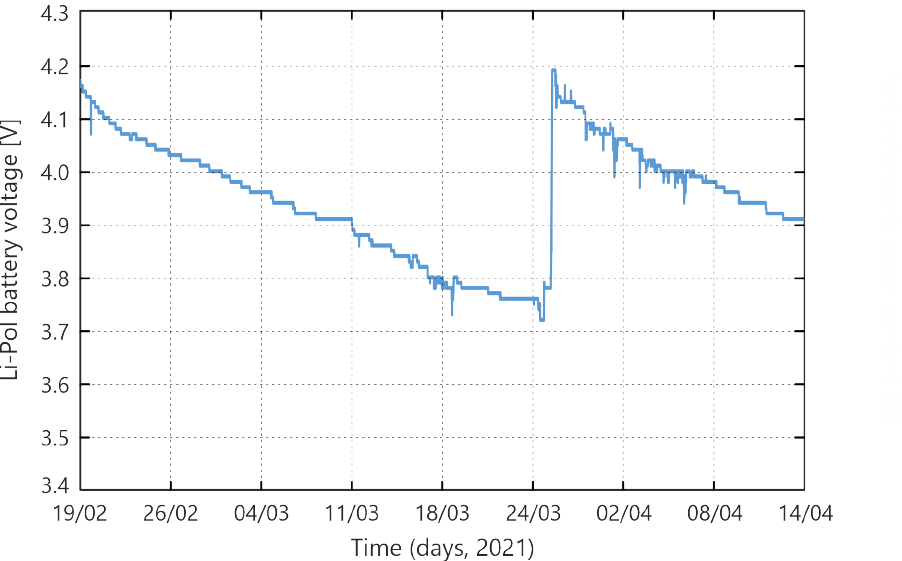
Figure 4. SPWAS’21 Battery voltage during normal field operation, with data transmission using the GPRS module GL865 QUAD V3 to mySense web/cloud server every half hour to accelerate battery